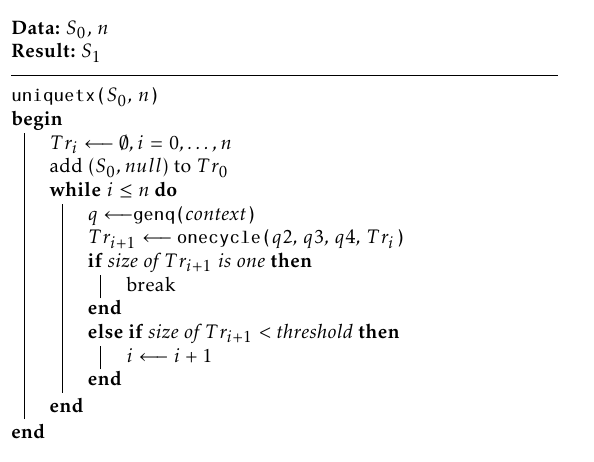
Algorithm 5: uniquetx : Compute programs that transform a given initial state to a unique final